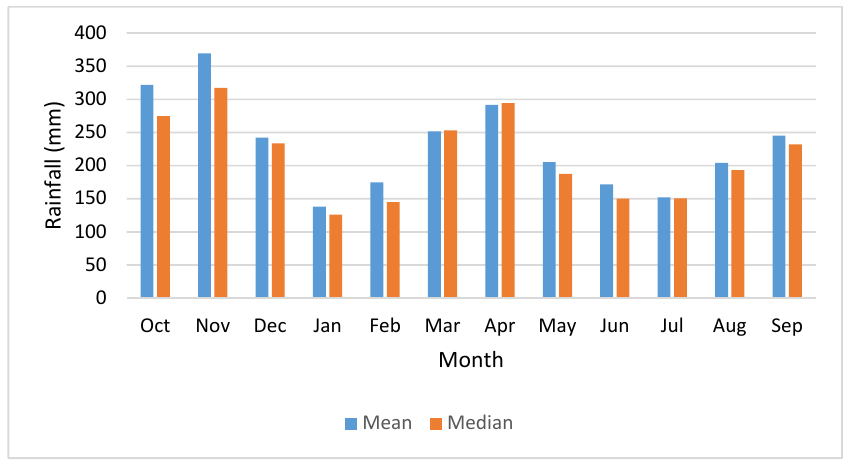
Figure 4. Monthly rainfall distribution at station 2, estimated using data from 1986 to 2016.